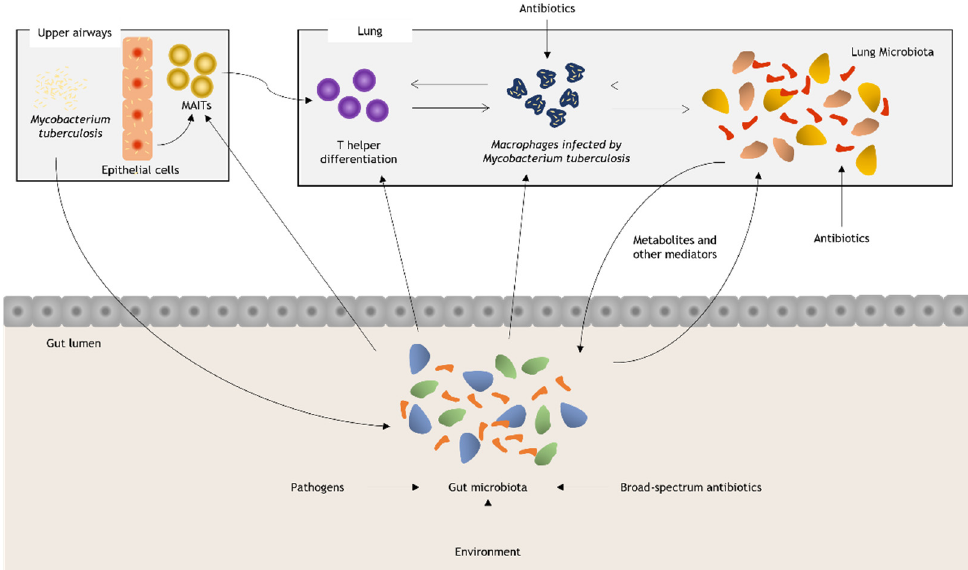
Figure 1. Environmental alterations such as diet, the use of broad-spectrum antibiotics, and colonization by pathogenic bacteria can alter the normal composition of the intestinal microbiota. M. tuberculosis , through mostly unknown mechanisms, is also able to modulate the diversity of the intestinal flora. The response of upper pathway epithelial cells and resident invariant T lymphocytes (MAITs) is modulated by the gut microbiota. These can assist the macrophage response to infection. The intestinal microbiota is a strong modulator of the T helper response in the lung and, as such, could affect the ability of macrophages to eliminate M. tuberculosis through the increase in the production of IFN- γ , IL-12, and reactive oxygen species. Bacterial-derived metabolites and other mediators are among those responsible for maintaining the dynamic balance between the intestinal and lung microbiota.